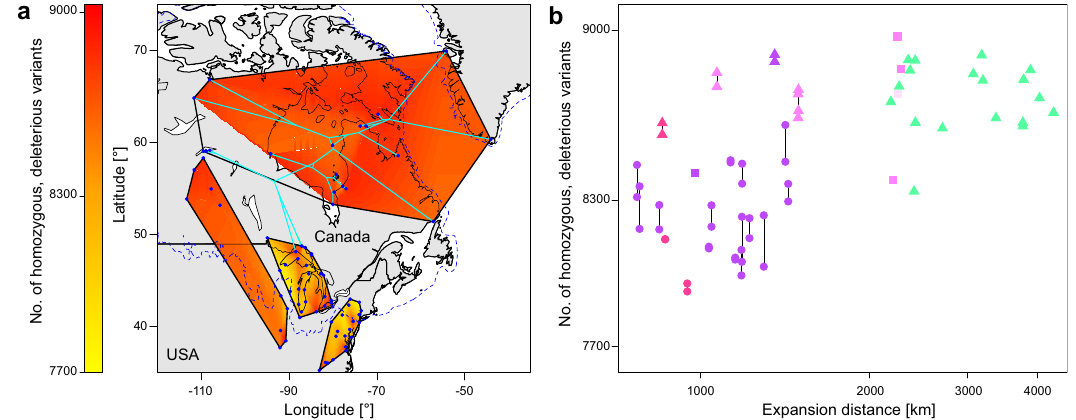
Fig. 4 | Mutational load. a Map of interpolated mutational load (number of homozygous, moderate- and high-impact variants) across the eastern and two western clades of Arabidopsis lyrata and A. arenicola . Interpolation was based on population means when information of two individuals wereavailable(for most A. lyrata populations), or on one individual (all A. arenicola samples). Sampling sites are represented by blue dots. Also plotted in bright blue is the map-projected TreeMix tree, starting with the node from which the easterly mid-western popu- lations of A. lyrata and all A. arenicola appeared. No interpolation was performed for Saskatchewansamples with evidence of admixture(gray area within minimum convex polygon hull of A. arenicola ). b Mutational load plotted against the expansiondistanceofmid-western A.lyrata and A.arenicola .Symbolsindicatethe